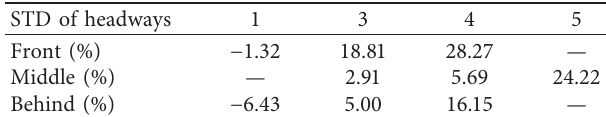
Table 5: STD of bus headways relative difference compared